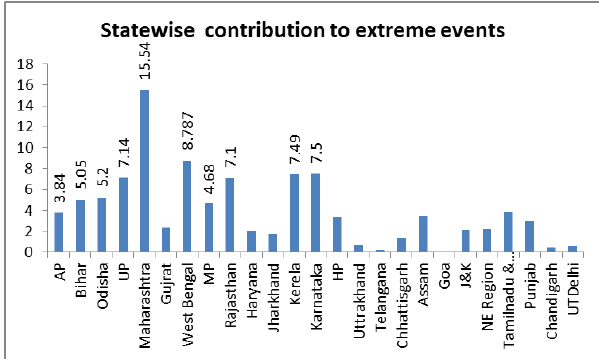
Figure 5. State wise contribution to extreme